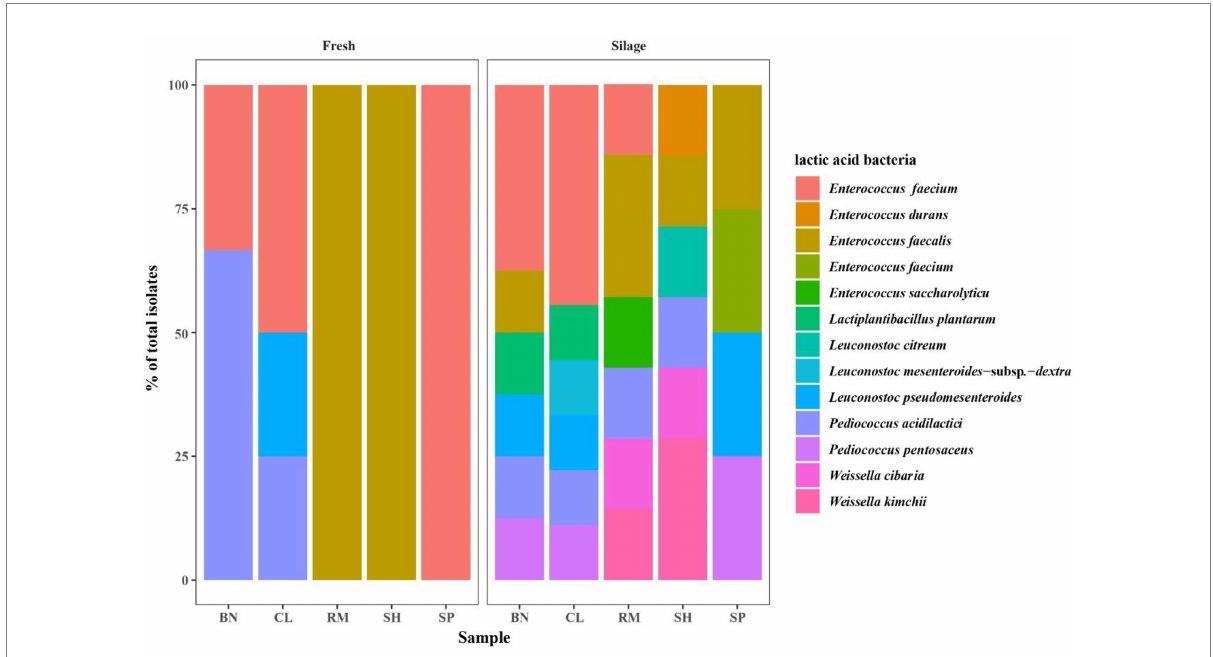
FIGURE 4 Community of lactic acid bacteria of native grass. BN, Baical Needgrass; CL, China Leymus; SH, Scabrous Hideseedgrass; RM, Ruthenia Medic; SP, Slenderleaf Pulsatilla.